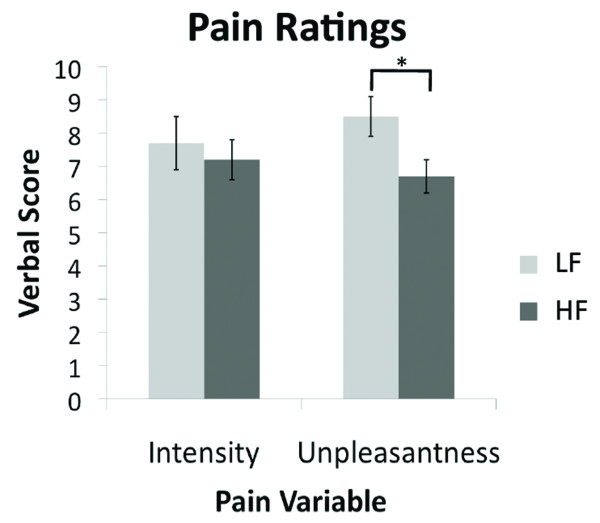
Migraine Pain Intensity and Unpleasantness Ratings. There is a significant difference in the pain unpleasantness scores between the two cohorts (p < 0.028). The scores are based on a 0-10 subjective scale for migraine pain intensity and pain unpleasantness.